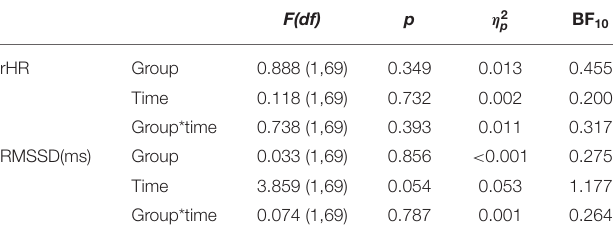
TABLE 3 | Results of the 2 × 2 ANOVAs (both frequentist and Bayesian) for the cardiovascular